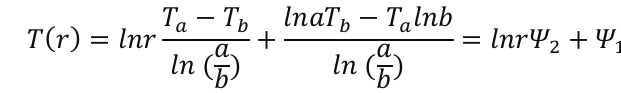
The solution of Eq. 6 for isotropic and homogeneous materials, μ = 0, under the same boundary conditions takes the form of (Eq. 8)